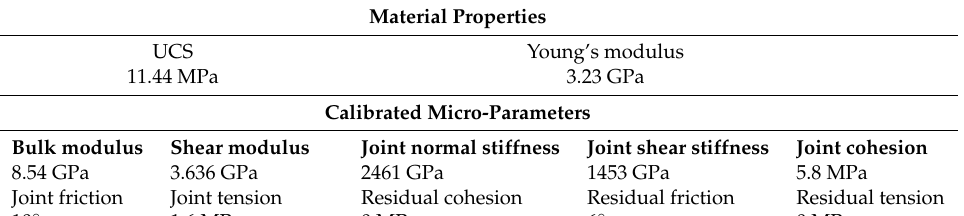
Table 1. Mechanical parameters of sample fitting in numerical model.